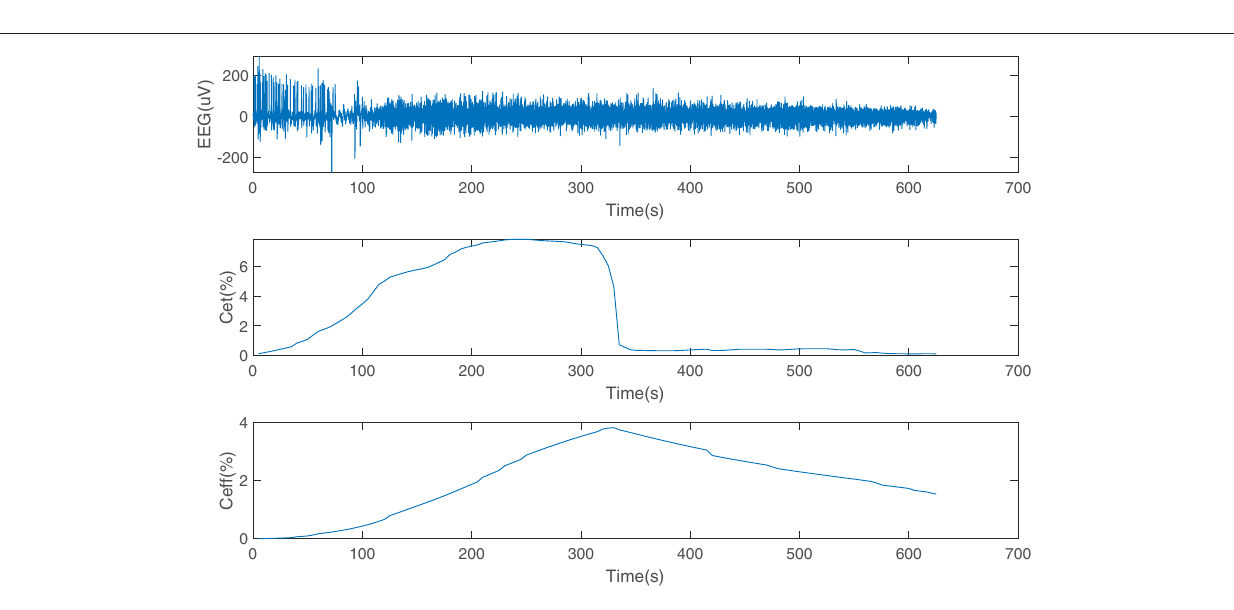
FIGURE 6 | EEG data from a patient and the end-tidal concentration and effect-site concentration of